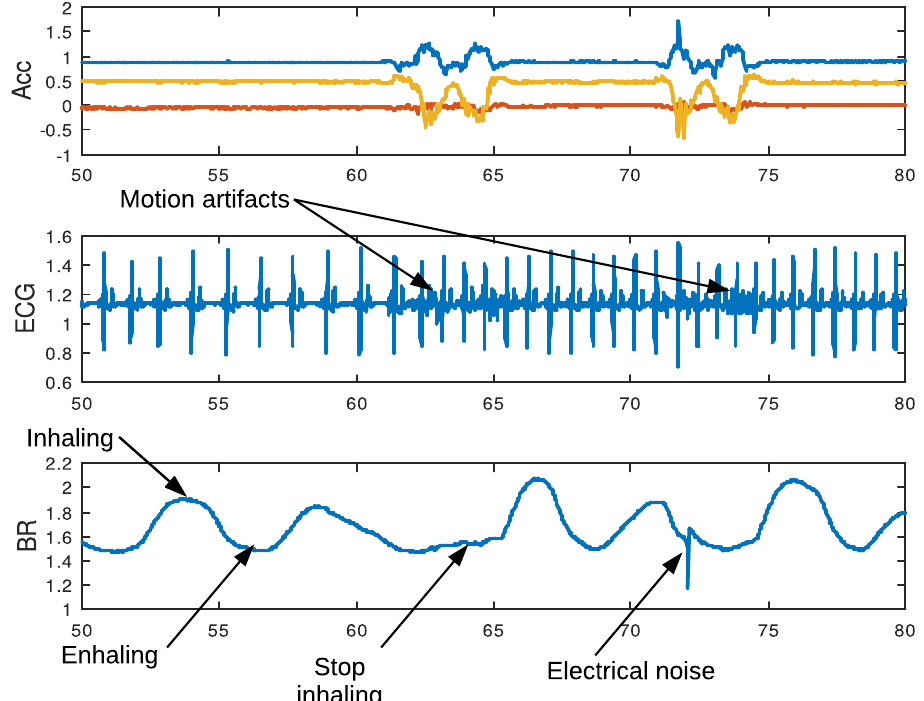
Figure 14. Artifacts and rhythm alterations in physiological signals during sit-to-stand exercise. A movement may cause motion noise in ECG, stop breathing, and poor electrode